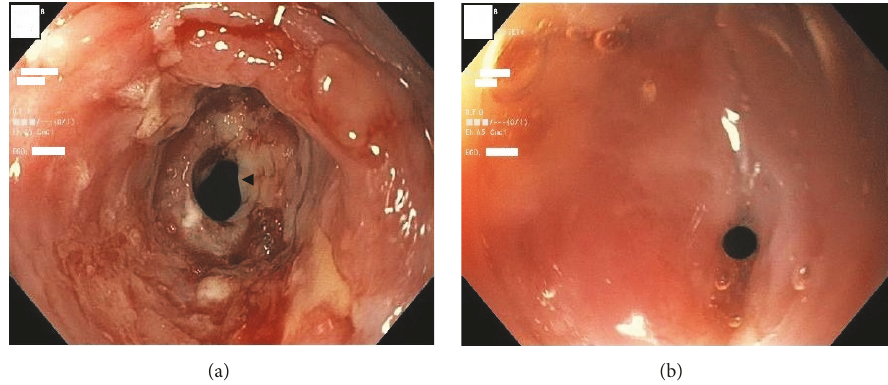
Figure 1: (a) Esophagogastroduodenoscopy (EGD) showing proximal esophageal inflammation and ulceration with a stricture at 15 cm from the incisors (arrowhead). (b) Repeat EGD showing healing of the esophageal mucosa and a remaining esophageal stricture.